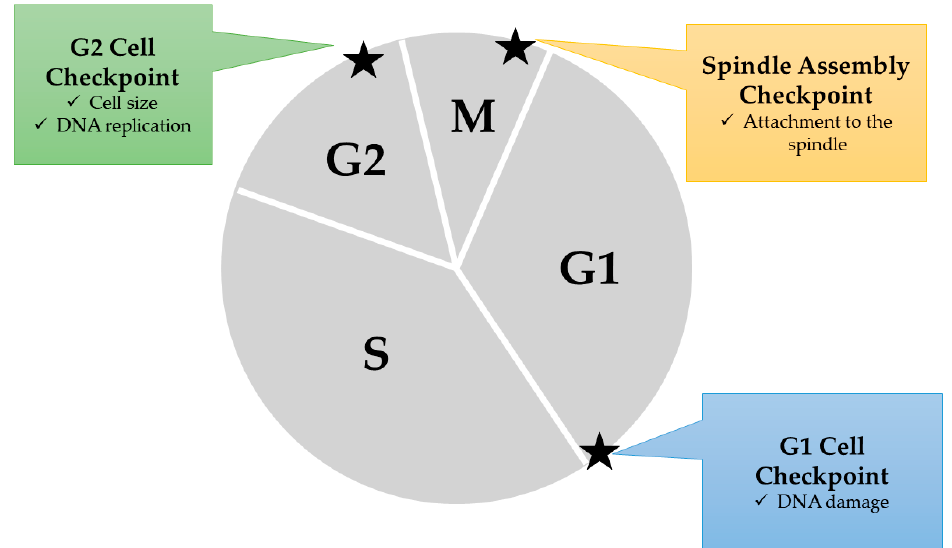
Figure 3. Cell cycle checkpoints inducing cell cycle arrest. Three points in the cell cycle are usually determined for normal cell growth. At the G1 cell checkpoint, when DNA damage is observed, the cell automatically turns to the G0 state (resting state), thus stopping the cell from growing any further. At the G2 cell checkpoint, the cell size is observed and the DNA replication is examined. When either of these processes is not yet complete or erroneous, cell cycle arrest is induced. At the spindle assembly checkpoint, whether the chromosomes are attached to the spindle is